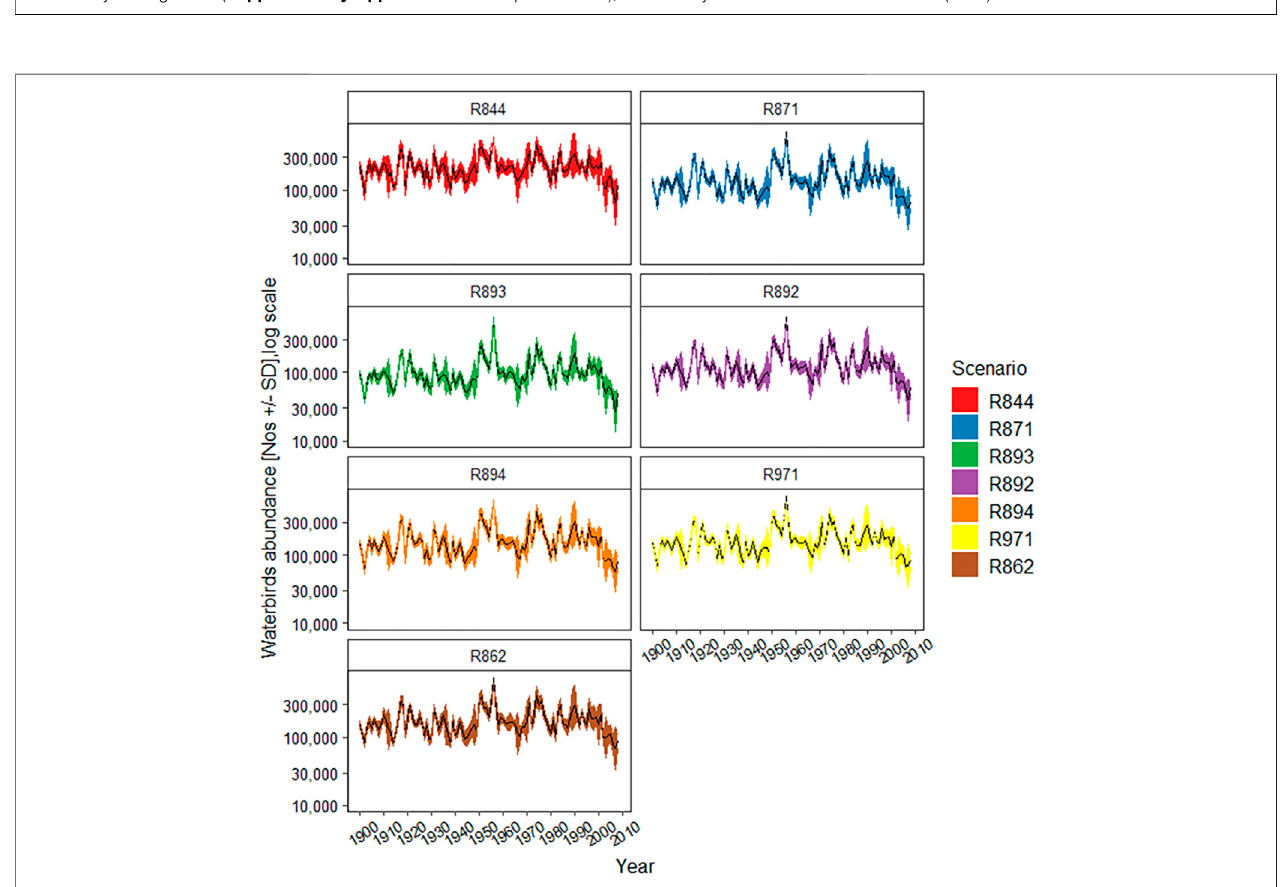
FIGURE 5 | Predicted annual waterbird abundances based on GLMs (see Random Forest predictions in Supplementary Appendix S5 ) under the seven management/ fl owScenariosintheMurray-DarlingBasin1900 – 2008(MDBA,2011b):withoutwaterresourcedevelopment(R844),pre-BasinPlanwithhistoricalclimate (R871),without-developmentscenario(R844),reducedannualdiversionsof2,750 GL(R971)and3,200 GL(R862),andclimatechange1 ° CincreaseontheR871under a dry (R893), medium (R892) and wet (R894) near future climate for the year 2030 (Chiew et al., 2010).